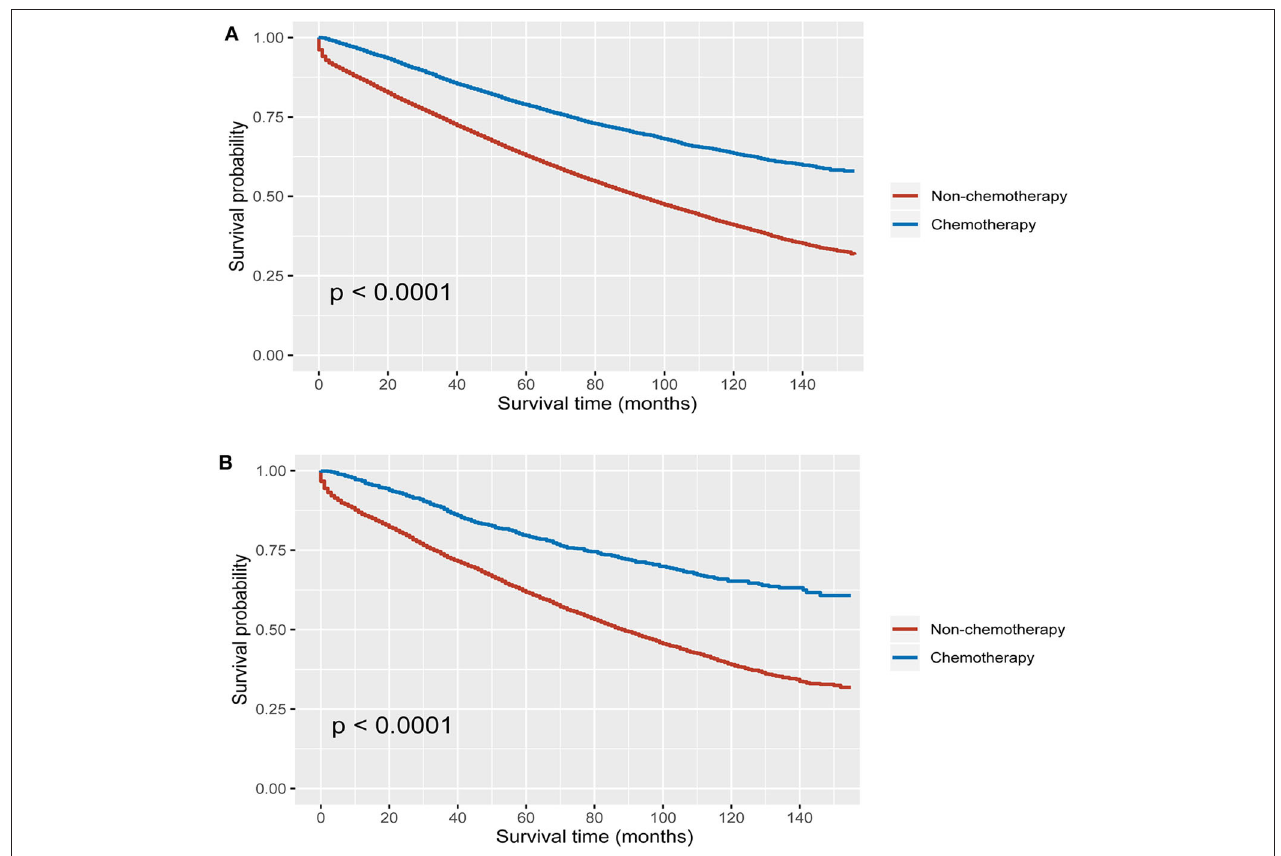
FIGURE 3 | Kaplan–Meier curves for overall survival in stage II colon cancer ith (A) MUA, (B)